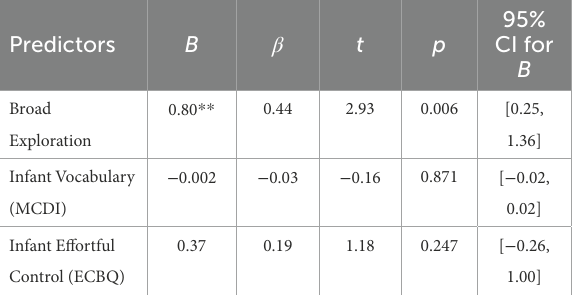
TABLE 6 Follow-up multiple regression analysis summary of Child Curiosity Subscale